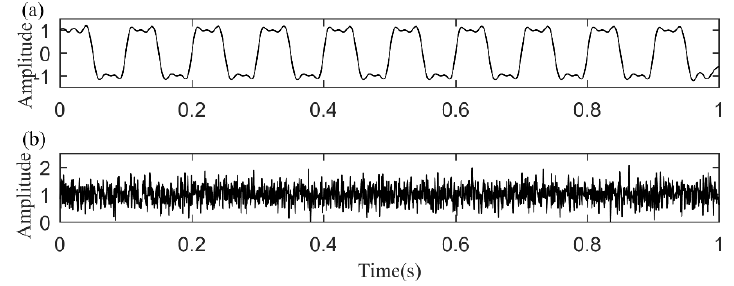
Figure 2. Filtering result of x 1 ( t ) . ( a ) Square wave component; ( b ) Residues.